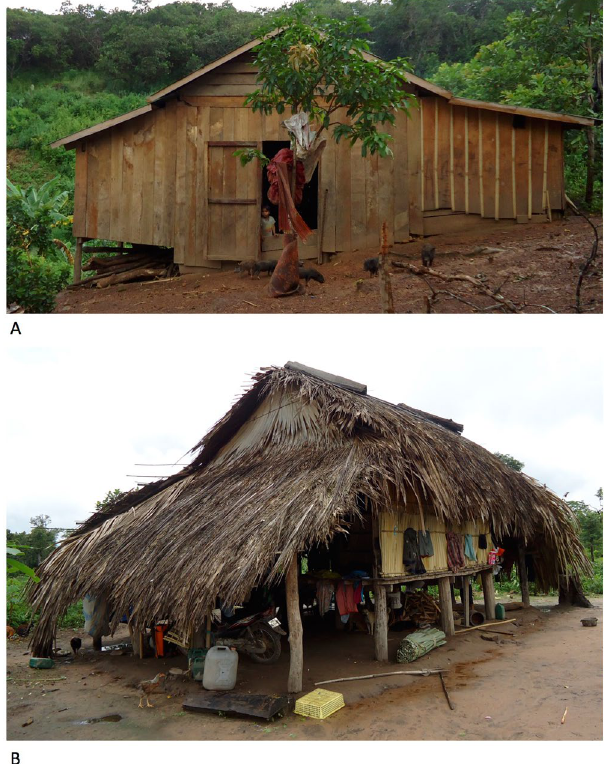
Figure 2. Example of different housing styles in the study villages. Panel A: Ground-level house constructed of wood walls and floor, and tin roof. Panel B: Elevated house constructed of bamboo walls and floor, and plant- based (palm frond) roof. Photographs taken by author Set